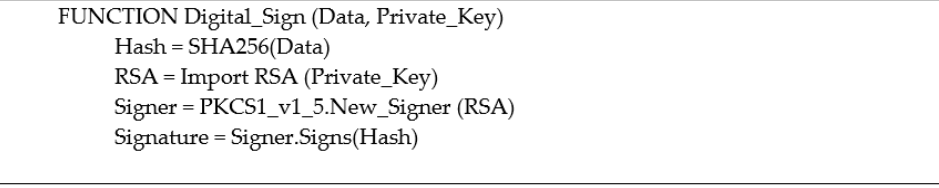
Figure 7. Digital signature pseudo code (sign).